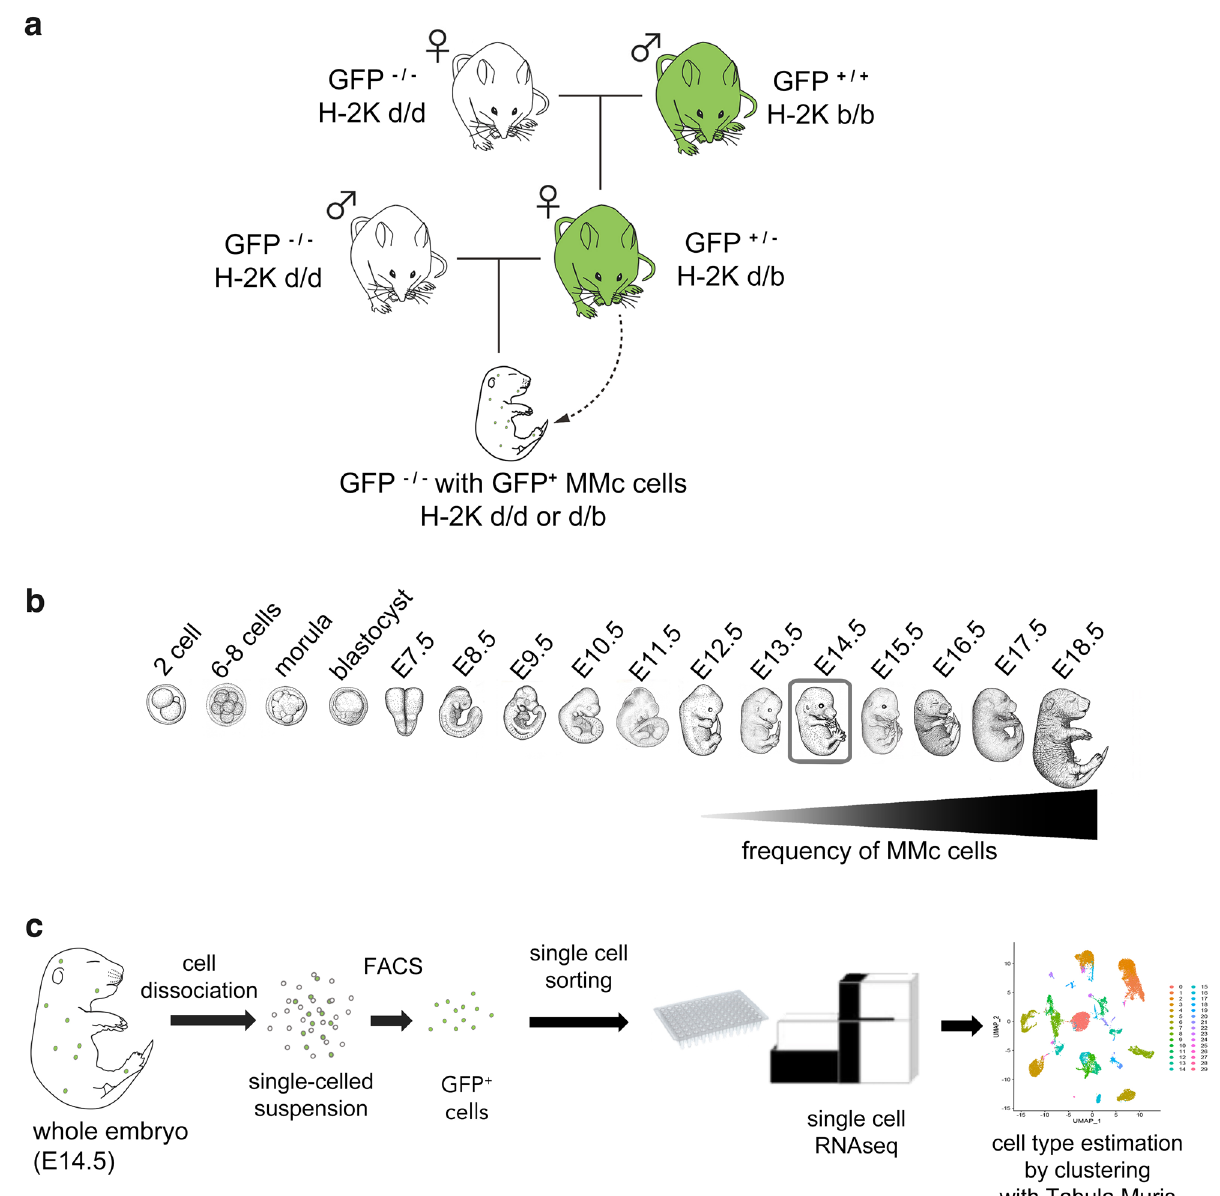
Figure 1. Experimental design for MMc cell isolation and cell type estimation. ( a ) To label MMc cells with GFP, transgenic mouse line [C57BL/6-Tg(CAG-EGFP)C14-Y01-FM131Osb] expressing GFP systemically was used. To avoid detecting grand-maternal cells as MMc cells 22 , GFP -heterozygous female mouse was first obtained by mating wild-type female mouse and a GFP -homozygous transgenic male mouse. Then, the GFP -heterozygous female, the mother mouse was mated with wild-type male mouse to obtain GFP-negative fetuses, which contained GFP-positive MMc cells. In addition, MMc cells were enriched based on differences in the major histocompatibility complex (MHC) using magnetic cell sorting: in the GFP -heterozygous mother mouse, H-2Kd/b was displayed as MHC class II molecule on the cell surface; in the fetus, H-2Kd/d or d/b would be displayed and hence, MMc cells in one in two embryos would be enriched using magnetic cell sorting. ( b ) Migration of MMc cells are reported to starts at around mouse embryonic stage E12.5–E13.5 23,24 , and the frequency of MMc cells increases as the fetal development proceeds, peaking at delivery. The number of MMc cells at the early embryonic stages was under the detection limit of the technique used in the current study. Hence, stage E14.5 embryo was used to detect MMc cells in the early migratory phase. ( c ) Overall experimental flow from whole-embryo dissection to MMc cell type estimation. E14.5 whole mouse embryo was processed using a whole-embryonic dissociation method developed previously 20 . Dissociated cell suspension from a single embryo was subsequently processed using magnetic cell sorting and flow cytometric cell sorting to isolate GFP- positive, live MMc cells, followed by scRNA-seq. MMc cell type was determined by mixed-clustering analysis with publicly available reference scRNA-seq data (TabulaMuris dataset 26 ). Manual drawing, together with Adobe Photoshop (https:// www. adobe. com, Photoshop 2021) were used to create the